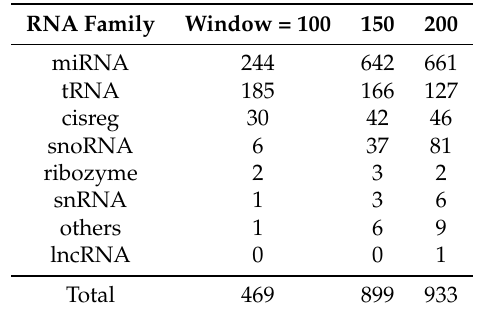
Table 1. Benchmark dataset. RNA